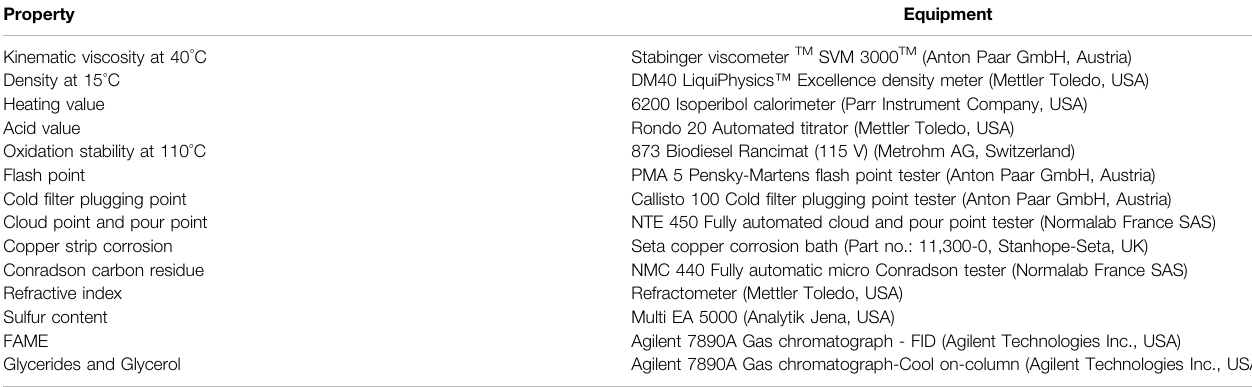
TABLE 2 | List of equipment used to measure the physicochemical properties of the W70CI 30 biodiesel and the blending fuel. Property Equipment